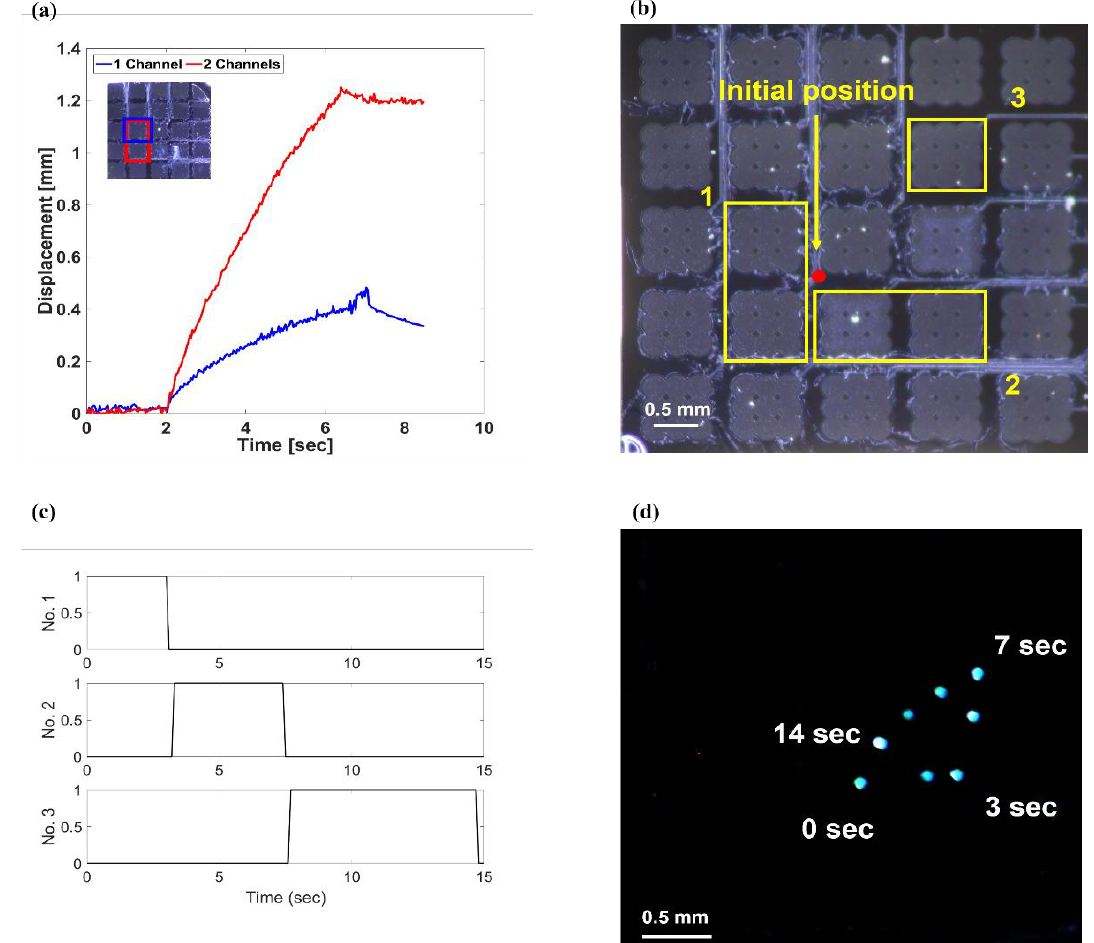
Figure 7. ( a ) Particle velocity operating on single and double channels; ( b ) operating channels for triangular manipulation; ( c ) input signal sequence for triangular manipulation; ( d ) stacked images of triangular